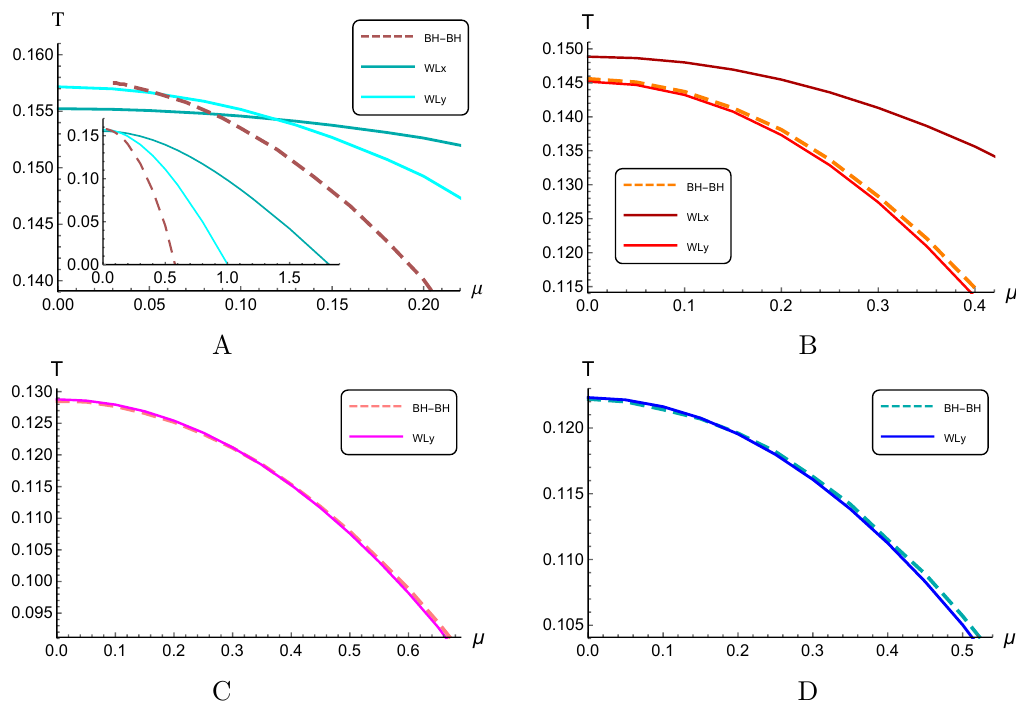
Figure 22 . Confinement/deconfinement phase diagram T ( µ ) for ν = 1 . 03 (A), ν = 1 . 5 (B), ν = 3 (C), ν = 4 . 5 (D); a = 4 . 046 , b = 0 . 01613 , c = 0 . 227